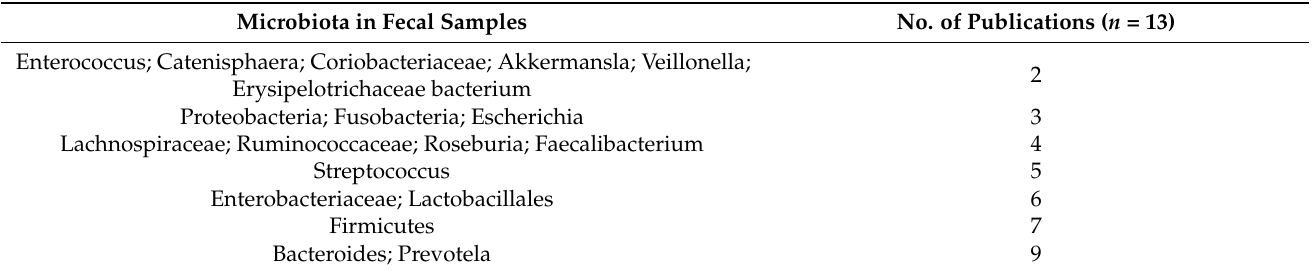
Table 3. Microbiota commonly identified by at least two publications in the fecal samples of those with coronary heart disease.